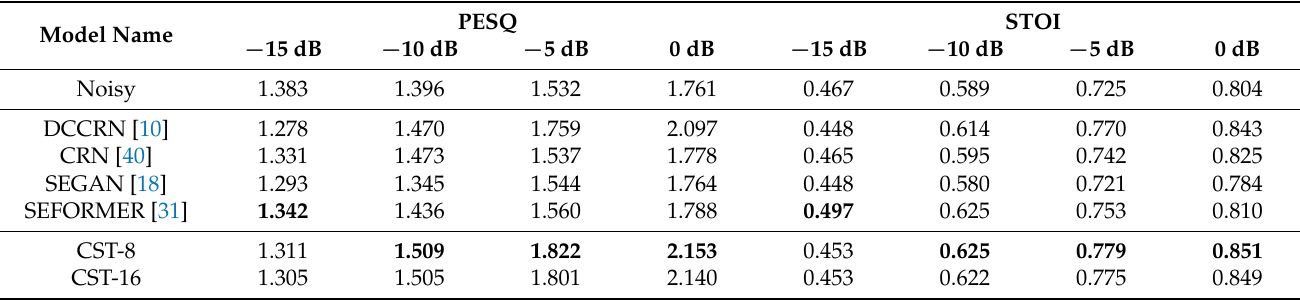
Table 2. Compare performance with other models in the Babble test set.